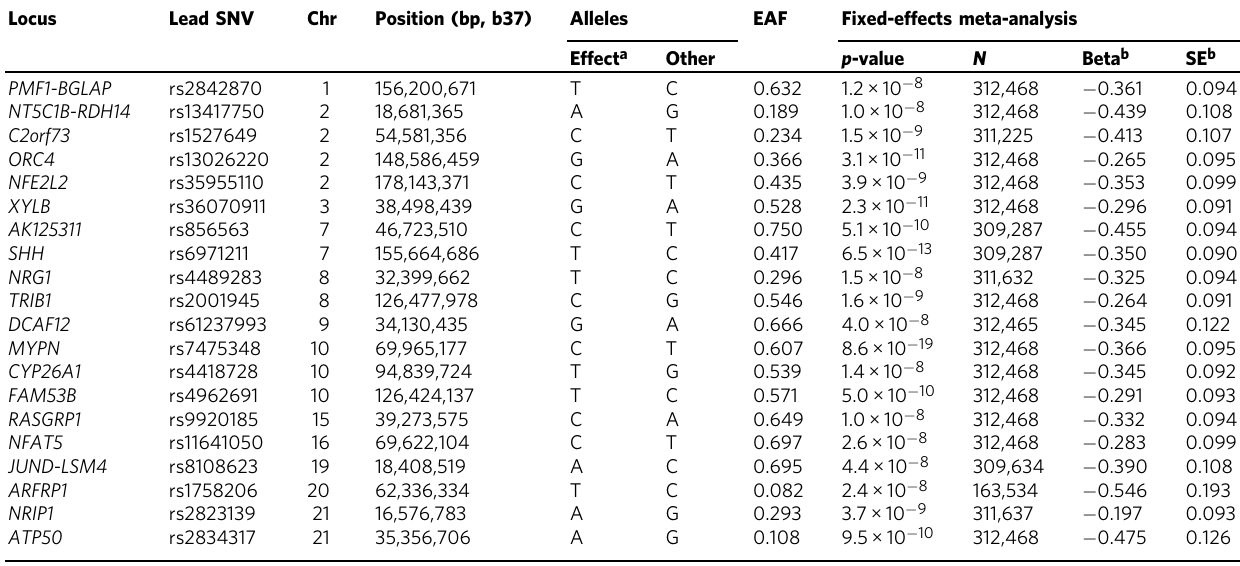
Table 1 Novel loci attaining genome-wide signi fi cant evidence ( p < 5 × 10 − 8 ) of association with eGFR in trans-ethnic meta- analysis of up to 312,468 individuals of diverse ancestry Locus Lead SNV Chr Position (bp, b37) Alleles EAF Fixed-effects meta-analysis